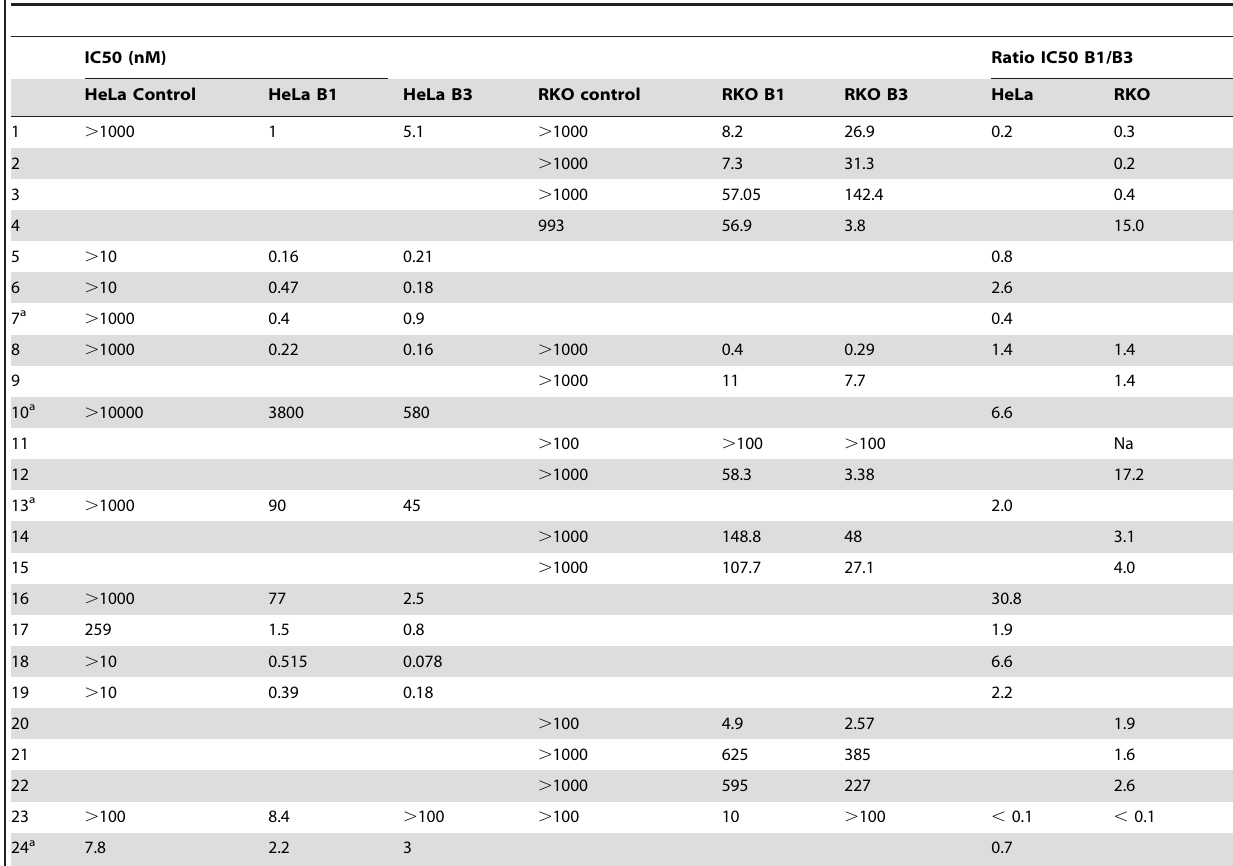
Table 2. IC 50 values of MC congeners (1-23) and okadaic acid (24) against stably transfected HeLa or RKO cell lines expressing either OATP1B1 or